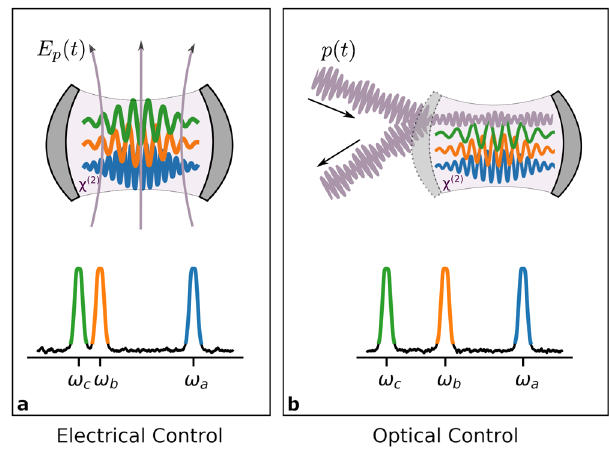
Fig. 1 The triply-resonant nonlinear cavity. The χ (2) medium enables the joint control of three modes. We denote the mode operators respectively by ^ a , ^ b , and ^ c . The χ (2) medium enables frequency doubling from ^ b to ^ a , and a three-way interaction between modes ^ b , ^ c , and the control fi eld. The control fi eld is either a a classical microwave drive, E p ( t ), or b a classical optical drive of envelope p ( t ). This three-way interaction is effectively a linear interaction between modes ^ b and ^ c that is controlled by the classical drive. The combination of the fi xed frequency-doubling interaction and the controlled linear interaction allows extensive control of the joint nonlinear evolution. This evolution conserves the quantity 2 n a + n b + n c , in which n a , n n b , and c are the occupation numbers of the respective modes. We also depict the relative values of the frequencies of the three modes; in a , the frequencies of modes ^ b and ^ c are separated by the much smaller frequency of the microwave